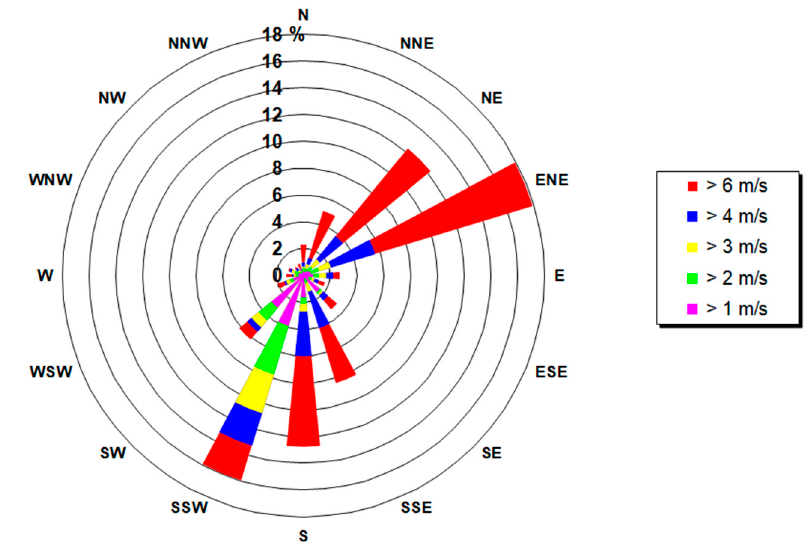
Figure 2. Wind rose at PRS for the year 2012 (RSE meteorological station).